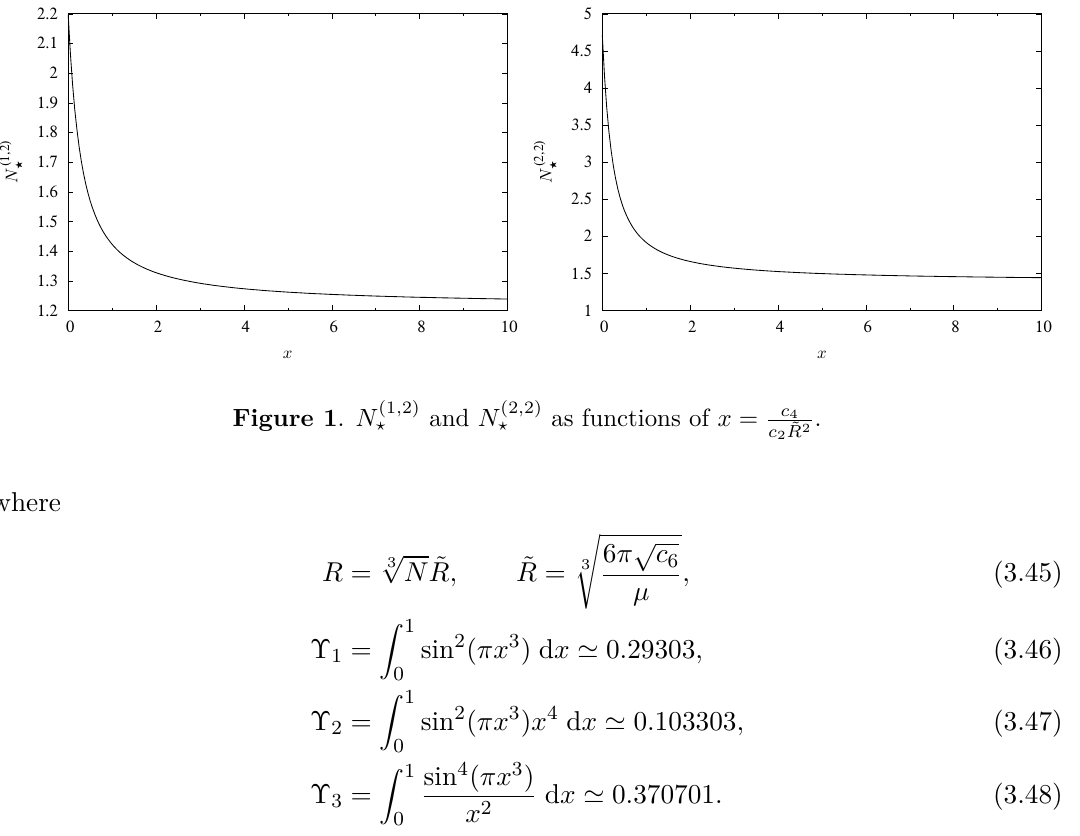
Figure 1 . N (1 , 2) ? and N (2 , 2) ? as functions of x = c 4